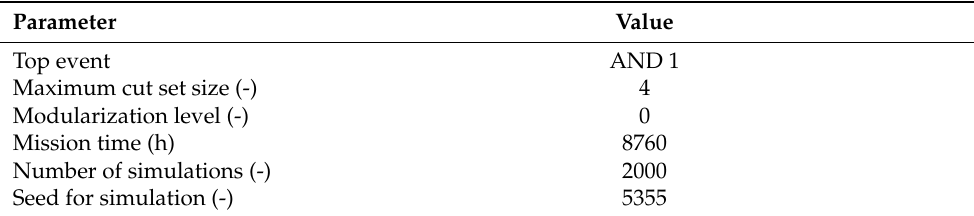
Table 2. Parameters of the performed